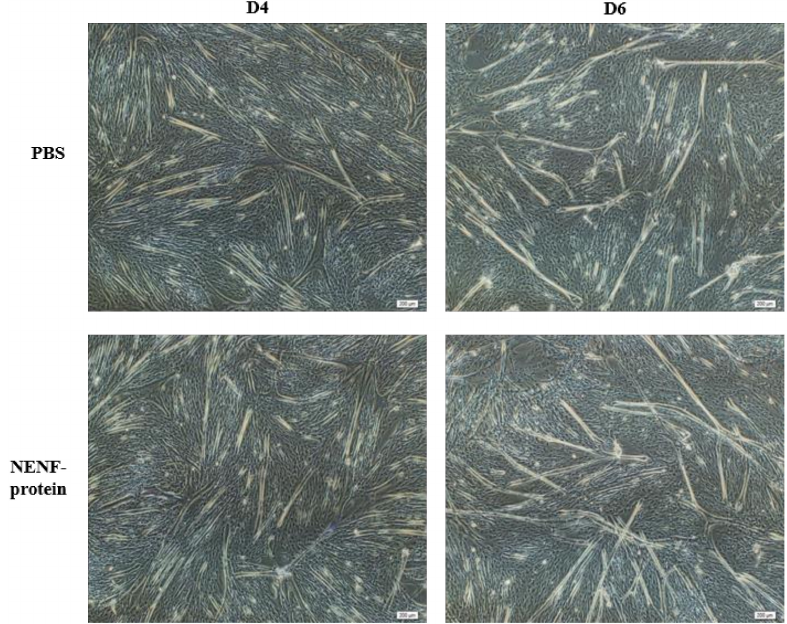
Figure 5. Effects of adding NENF recombinant protein on myoblast differentiation in co-culture system. Morphological changes of myoblasts after adding the recombinant protein NENF and PBS at 4th day of natural differentiation (D4) and 6th day of natural differentiation (D6). (OLYMPUS IX71 40 ×